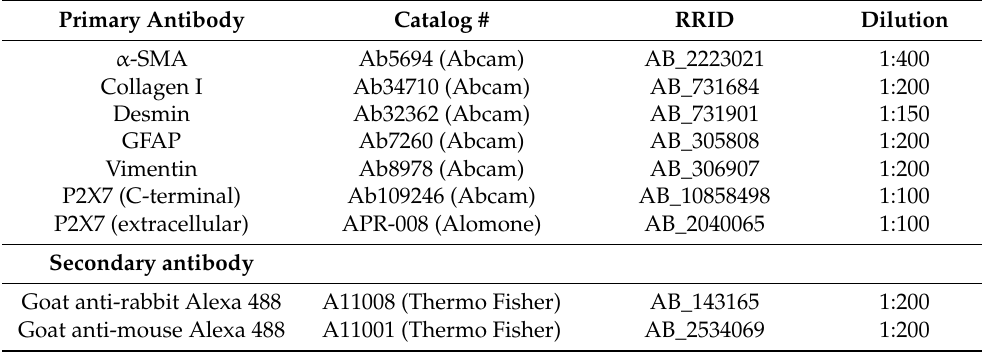
Table 2. Antibodies for